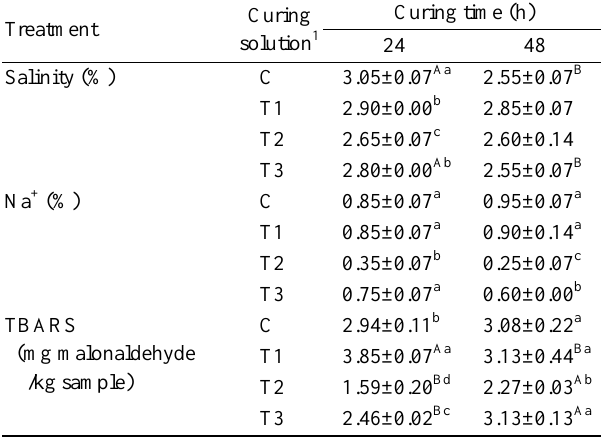
Table 2. Effect of curing time on the salinity, Na + concentration and TBARS of beef jerky Curing Treatment